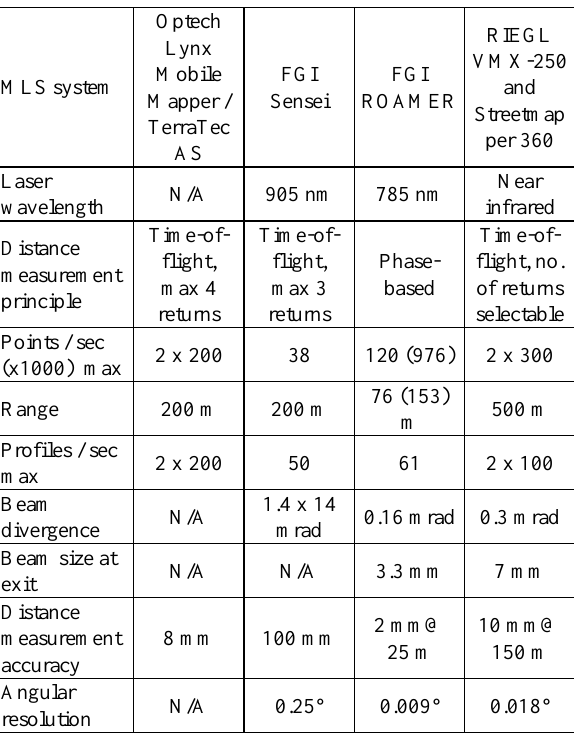
Table 2. System specifications, for ROAMER the current